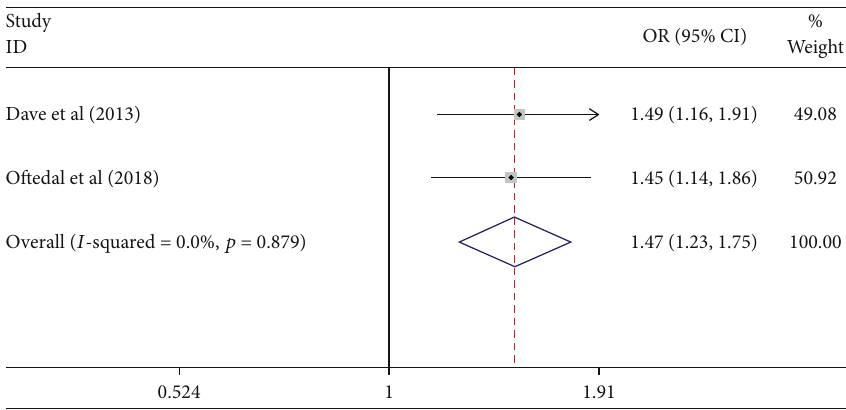
Figure 12: E ff ect size of triglycerides on the uncontrolled hypertension. Funnel plot with pseudo 95% confidence limits 0